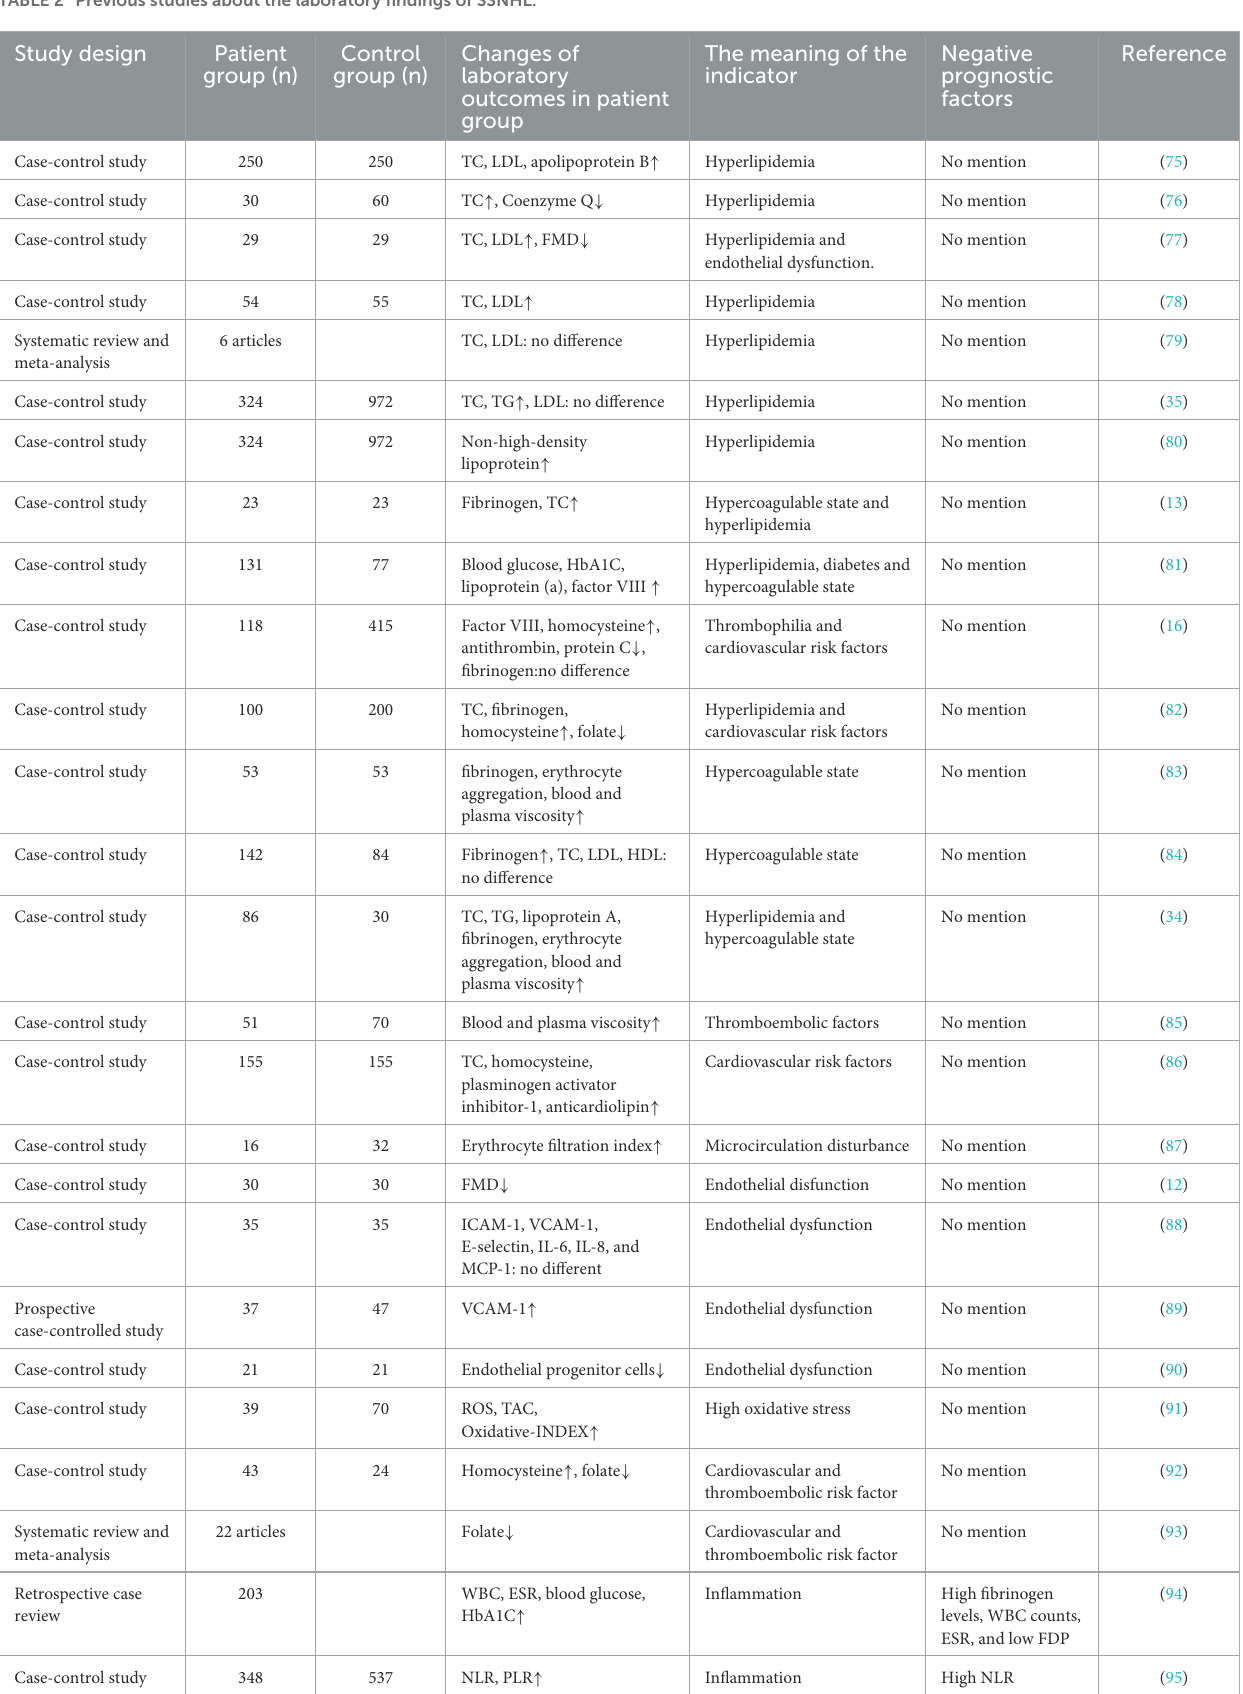
TABLE 2 Previous studies about the laboratory findings of